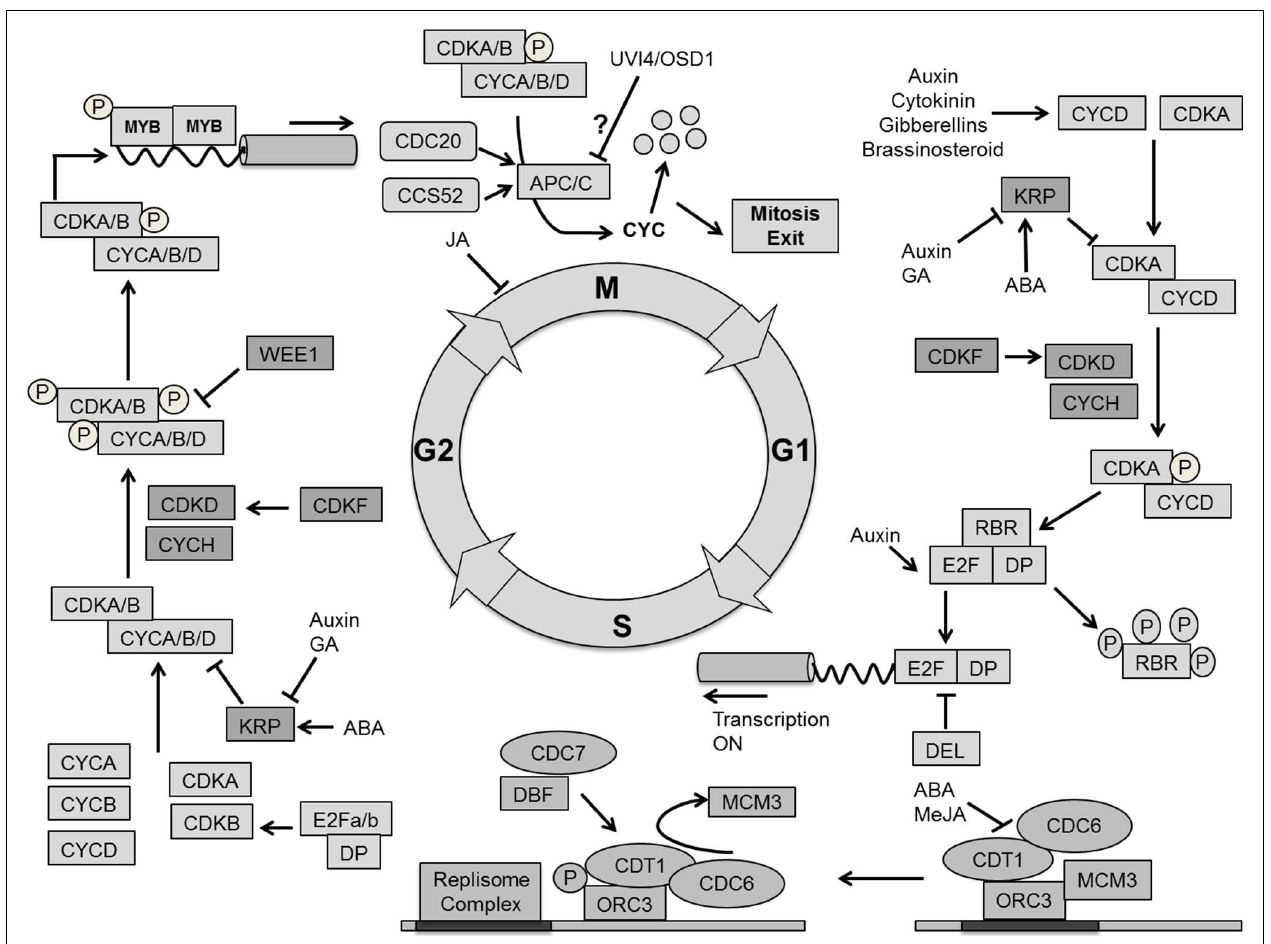
FIGURE 6 | Molecular mechanism for cell cycle regulation. Four phases of cell cycle (G1, S, G2, and M) are operated by successive activation and deactivation of cyclin dependent kinases (CDKs). During the cell cycle these kinases bind with cyclins and get activated through phosphorylation by CDK activating kinases (CDKD and CDKF) whereas KRPs inhibit the complexes. G1 to S transition is controlled by CDKA–CYCD which phosphorylates the RBR proteins and releases the E2F transcription factor, which activates S phase related genes.The G2–M transition is dependent on CDKA/B and CYCA/B/D.